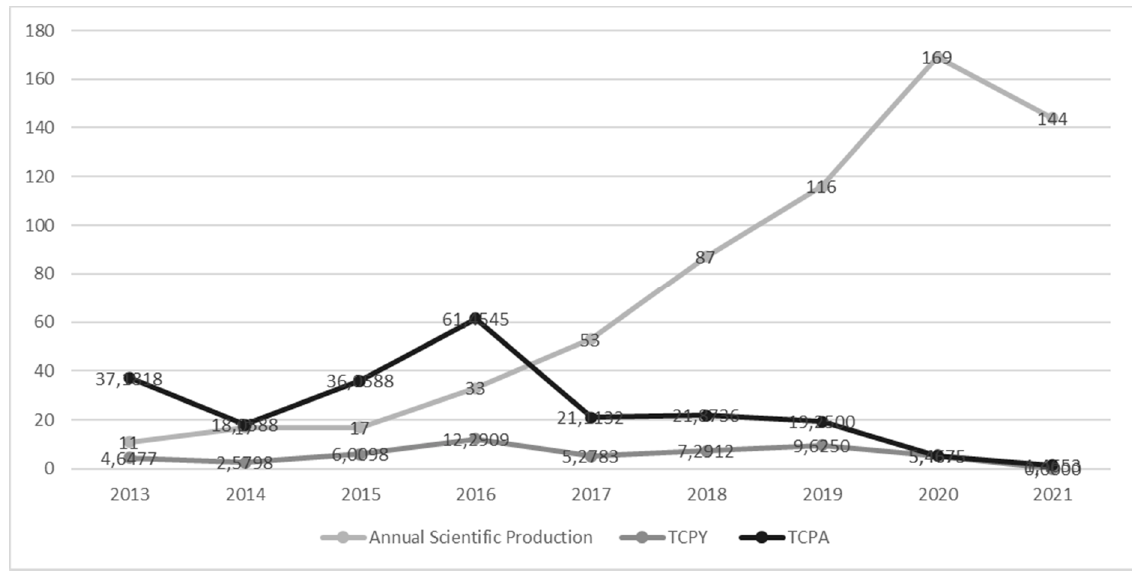
Figure 4. Annual research growth (TCPY: total citation per year, TCPA: total citation per article) .